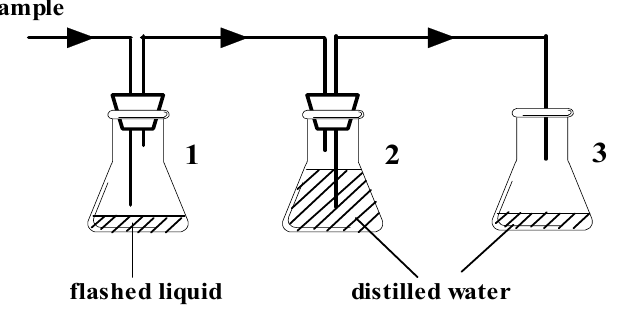
Figure 3. Schematic diagram of the liquid sampling